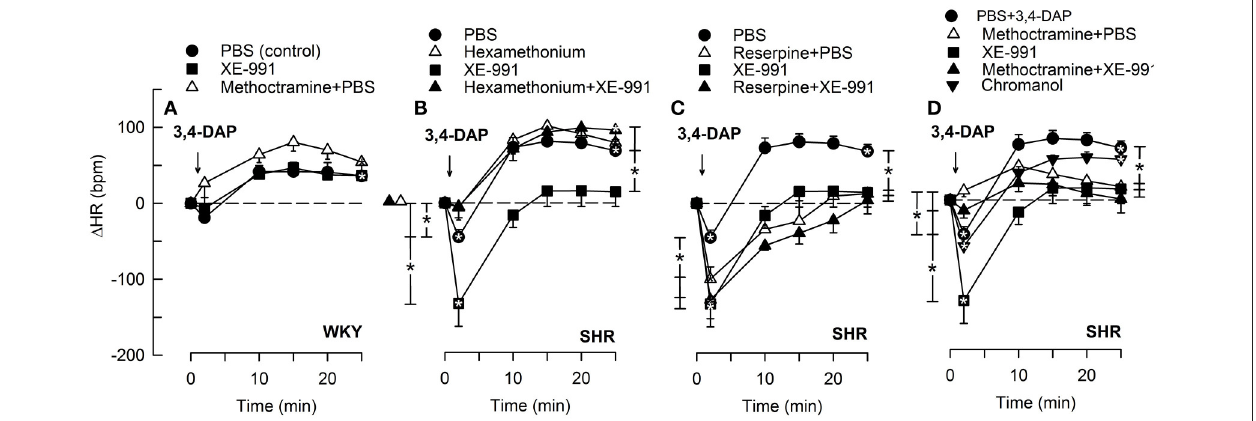
FIGURE 3 | The HR-response to 3,4-DAP after pre-treatment with the K V 7.1-7.4-inhibitor XE-991 in WKY (A) and SHR (B–D) , pre-treated as indicated by symbol legends. Significant responses (* within symbol) and group differences (* in brackets) at about 1 (recorded at the TPR-peak-response) and at 25 min were located as indicated. Comparisons were made between corresponding control and experimental groups, and between the SHR groups pre-treated with hexamethonium/reserpine/methoctramine alone and hexamethonium/reserpine/methoctramine + XE-991. * P < 0.025 after curve analyses.